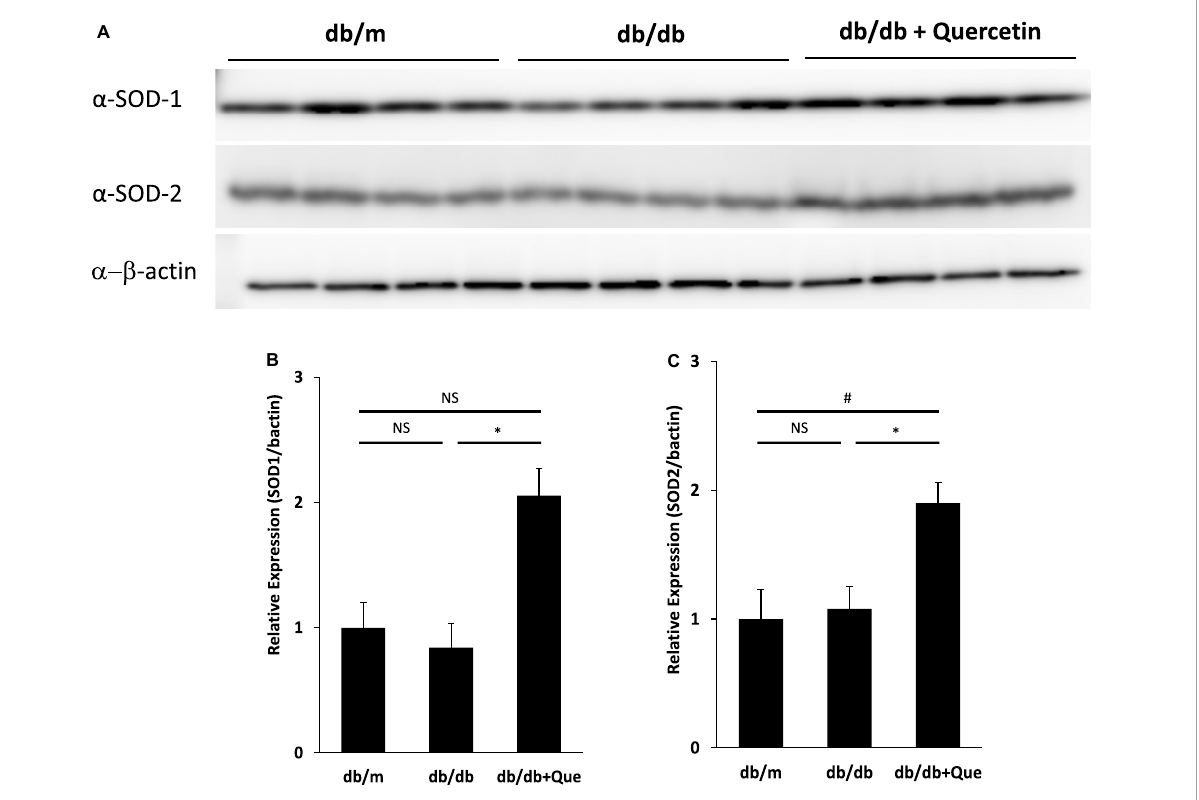
FIGURE3 Modulation of SOD in lacrimal glands by quercetin treatment. (A) Western blot analysis of lacrimal glands from the db/m, the db/db, and db/db + quercetin mice (each group, n = 4), using antibodies to SOD-1, SOD-2 and beta-actin. Relative protein levels of SOD-1 (B) or SOD-2 (C) normalized to beta-actin in whole tissue lysates. All data are presented as means ± SEM. Statistical significance was calculated by Bonferroni’s correction, ∗ P < 0.05 vs. db/db group, # P < 0.05 vs. db/m group. NS: not